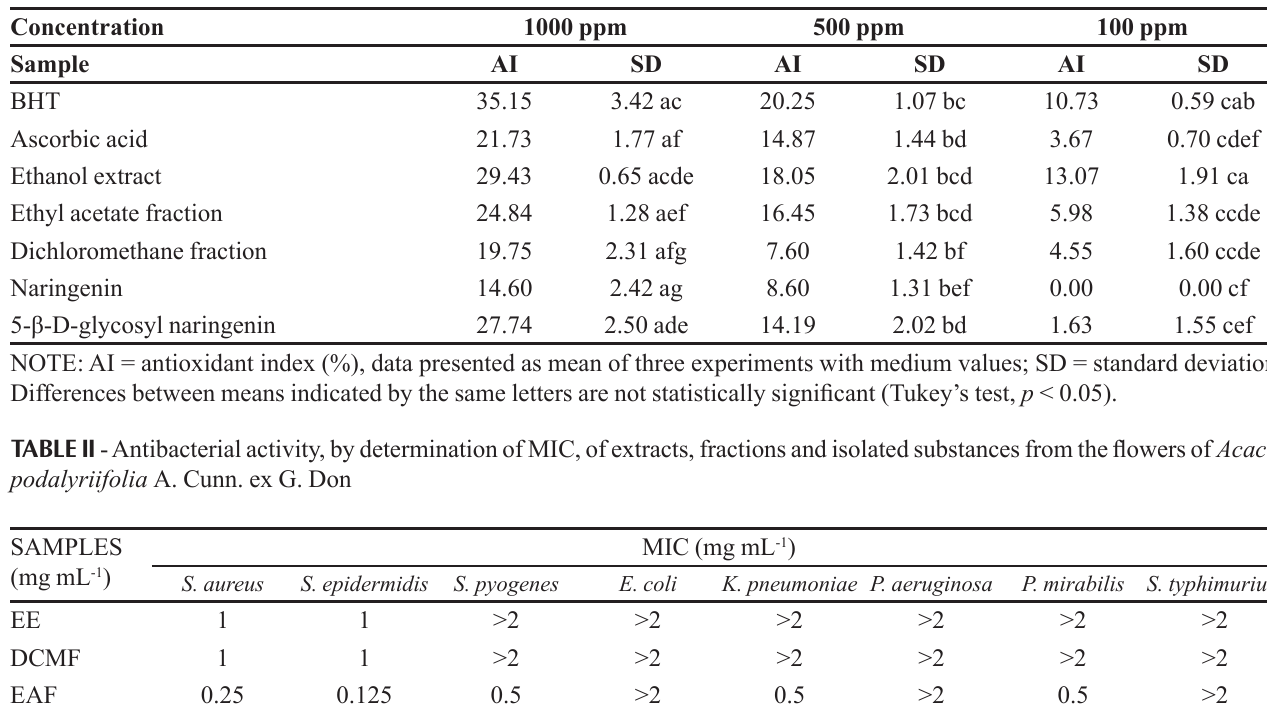
TABLE I - Antioxidant Index (%), obtained by TBARS test, of reference compounds and extracts, fractions and isolated substances from the flowers of Acacia podalyriifolia A. Cunn. ex G. Don